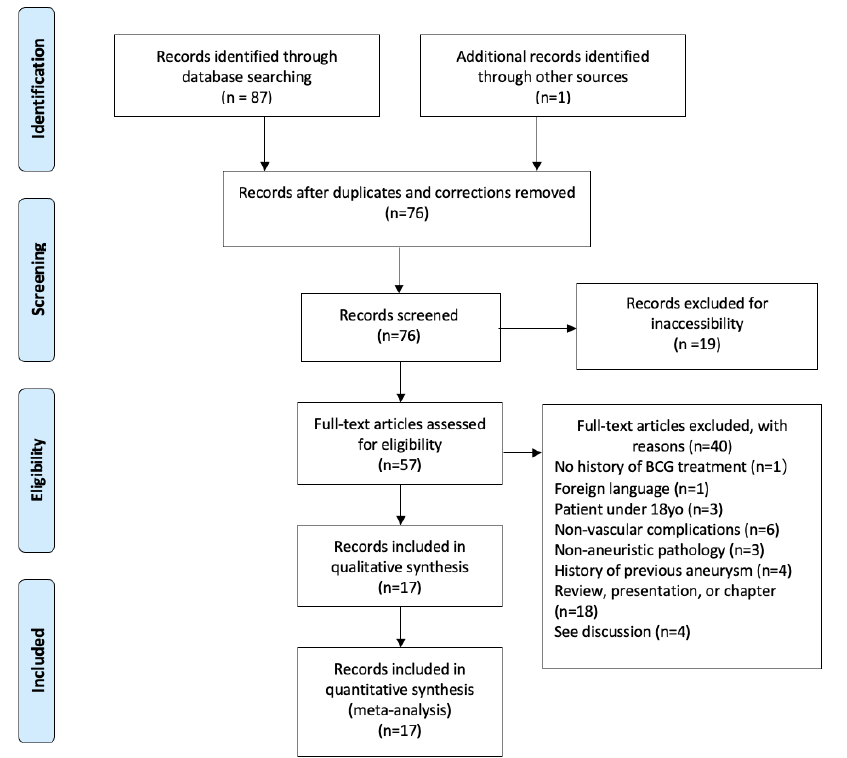
Figure 2. PRISMA (Preferred Reporting Items for Systematic reviews and Meta-Analyses) diagram of case report selections.